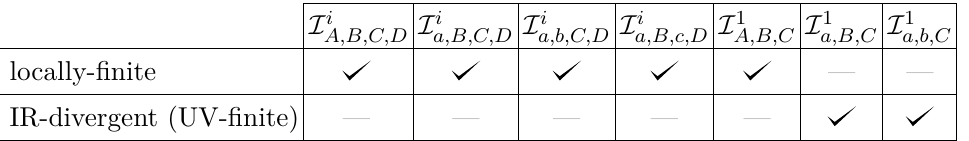
Table 1 . Properties of basis integrands defined in B (4) weight-2 in transcendentality when integrated in (4- 2 (cid:15) )